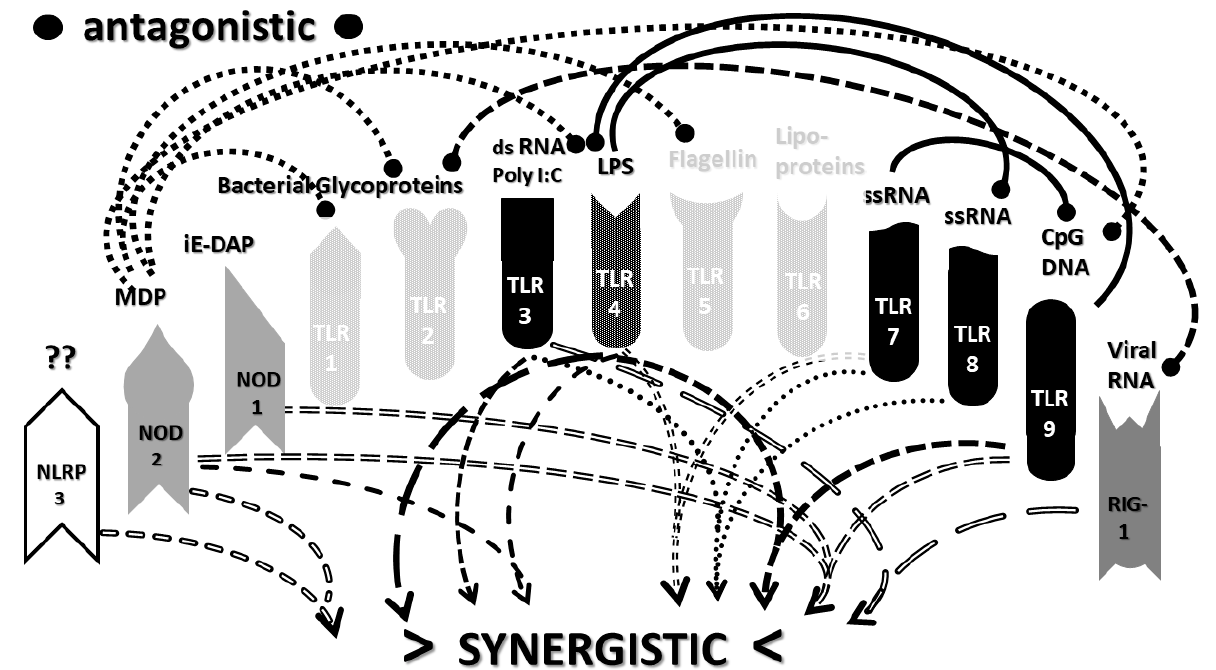
Figure 9. Innate receptor activation pattern resulting from a coinfection of the Influenza A virus and Haemophilus influenzae (as often occurred during the Great Influenza Pandemic of 1918–1919) [22,23]. Note the differences from Figures 3A and 8 (severe COVID-19 patients). Note also that there is an antagonistic effect of NOD2 activation on RIG1 and TLR9, an antagonism of TLR7 for TLR9 and an antagonism of TLR4 on TLR8 that may explain the absence of RIG1, TLR8 and TLR9 activation in influenza-associated ALI/ARDS (Table 1), despite the activation of RIG1, TLR8 and TLR9 by the influenza A virus (Table 2). It seems likely that other RIG1 and TLR8 antagonisms (e.g., from NOD1) also exist that are yet to be described. For other TLR, the number of synergisms outnumber the antagonisms, so these receptors will presumably continue to be activated.